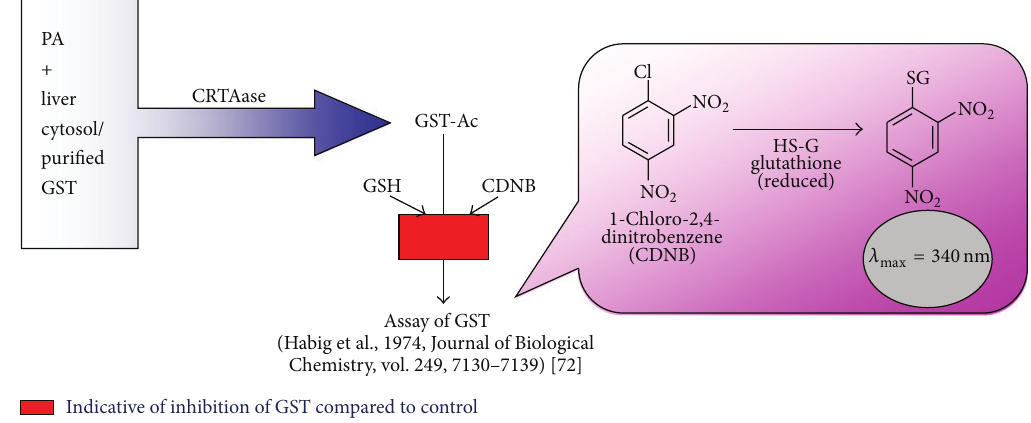
Figure 1: Assay for CRTAase. GST activity was assayed by the method of Habig et al., 1974 [72]. The extent of inhibition of GST activity under the conditions of assay was considered proportional to CRTAase activity. The unit of CRTAase activity was expressed in terms of percentage inhibition of GST activity